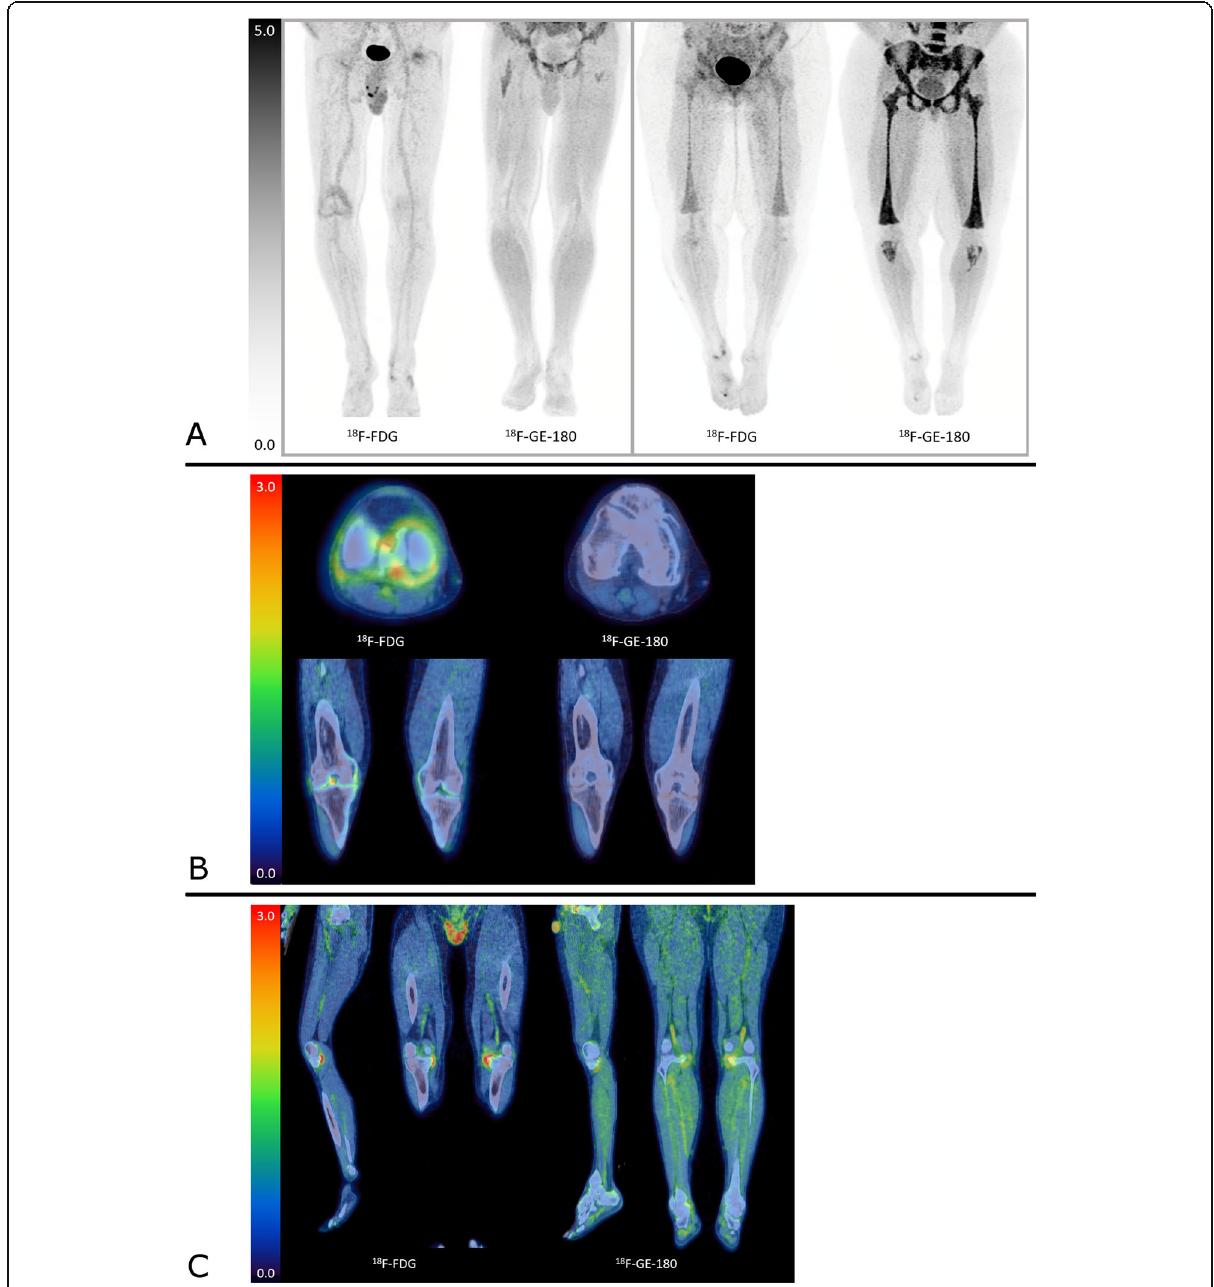
Fig. 1 Representative imaging. a demonstrates maximum intensity projections (MIPs) of two patients imaged with 18 F-FDG and 18 F-GE-180. The two left images are of a patient who has increased right knee joint uptake with 18 F-FDG, not seen with 18 F-GE-180, which is also demonstrated on axial and coronal fused images in b . The images with 18 F-GE-180 demonstrate a typical pattern of physiological uptake with marrow uptake in the proximal femurs and diffuse muscle uptake. The two right images of Fig. a are of a separate patient who demonstrates marked uptake within the marrow down to the proximal tibiae with 18 F-GE-180. A similar but less intense uptake is seen with 18 F-FDG and is presumed related to a reactive marrow. c are coronal and sagittal images of a patient with increased uptake in the medial aspects of both knee joints which is much more marked with 18 F-FDG, compared to 18 F-GE-180. The 18 F-GE-180 images also demonstrate increased muscle and marrow uptake. The scale on all figures is SUV